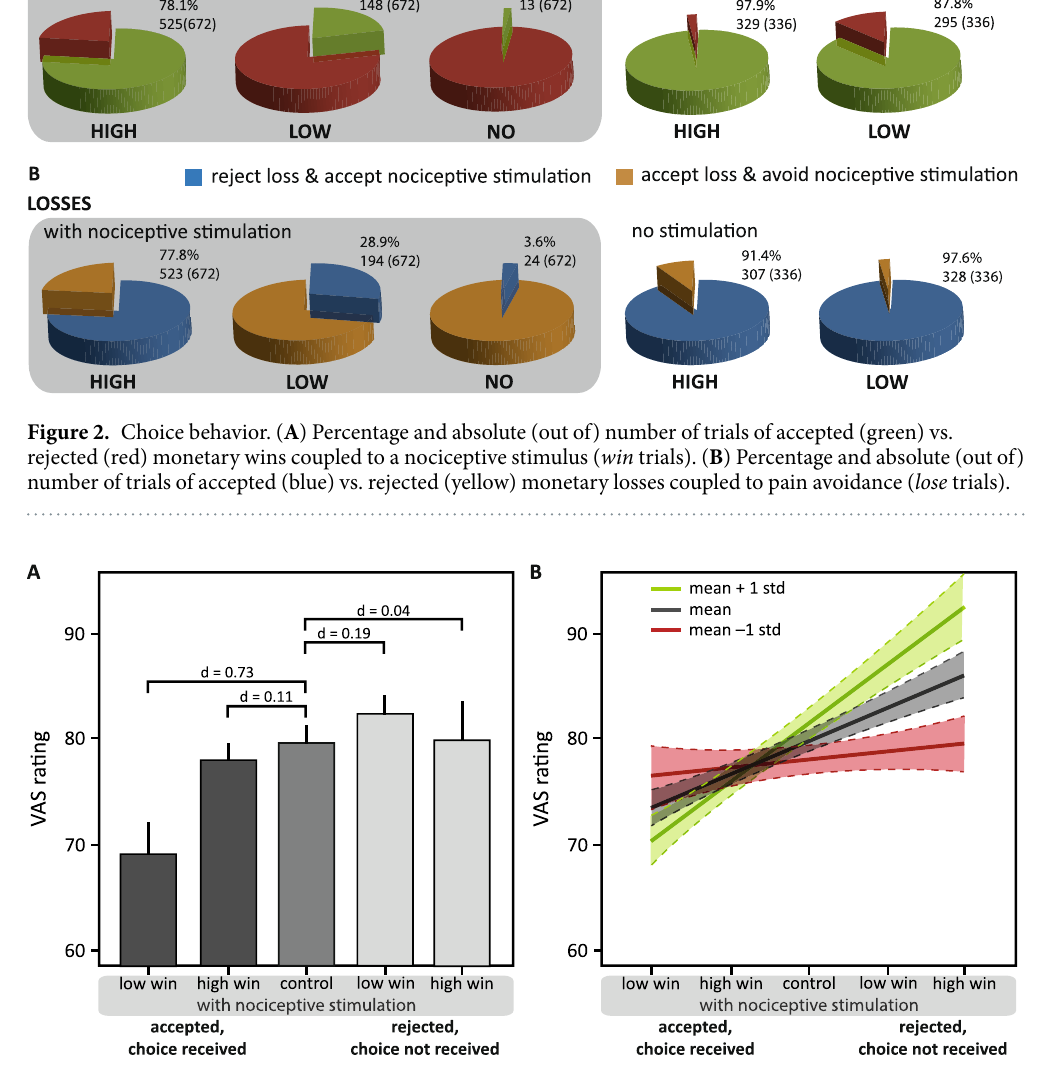
6 SCIeNtIFIC REPORtS | 7: 7790 | DOI:10.1038/s41598-017-08454-4